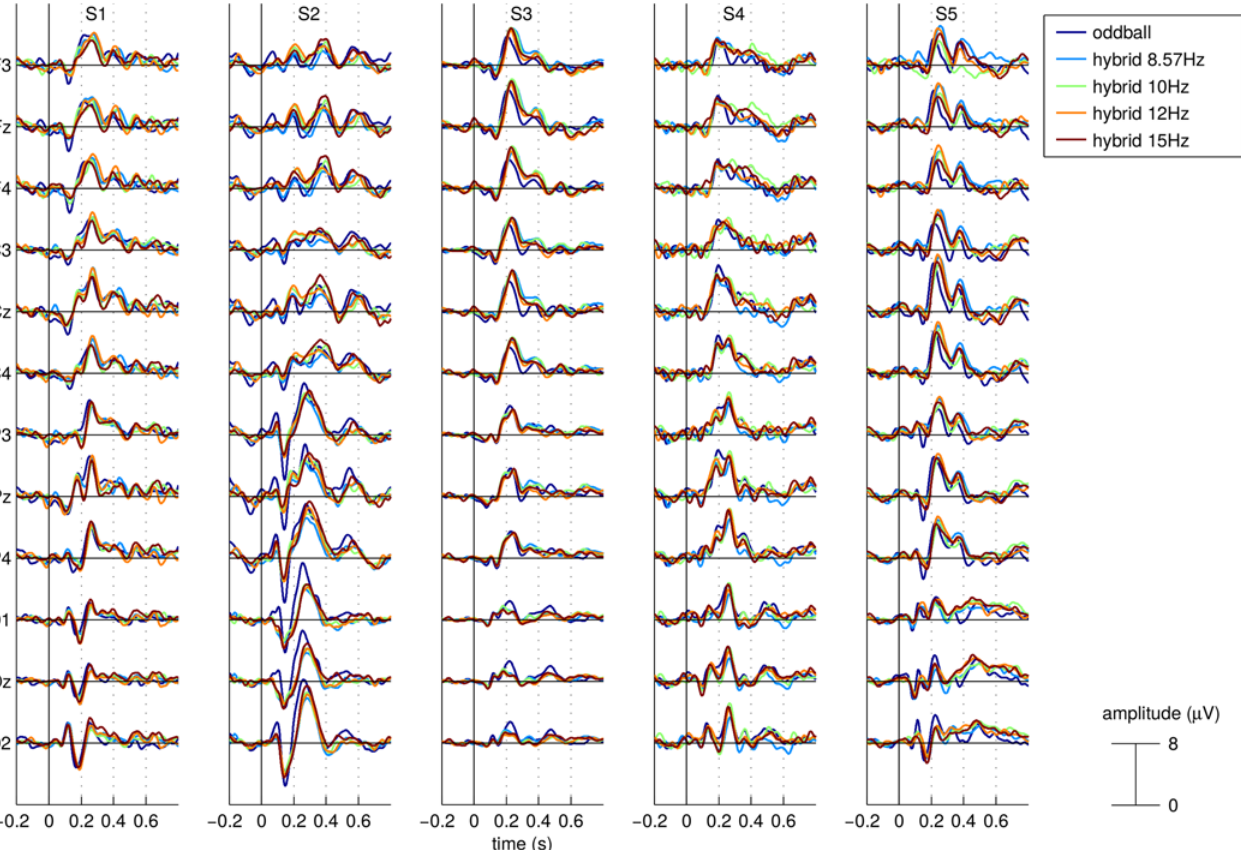
Fig 3. Average ERP responses to the target stimuli. ERPs are shown for a selection of EEG channels covering the scalp from frontal to occipital locations for all 5 experimental conditions and for subjects S01 to S05. Time 0 represents stimuli